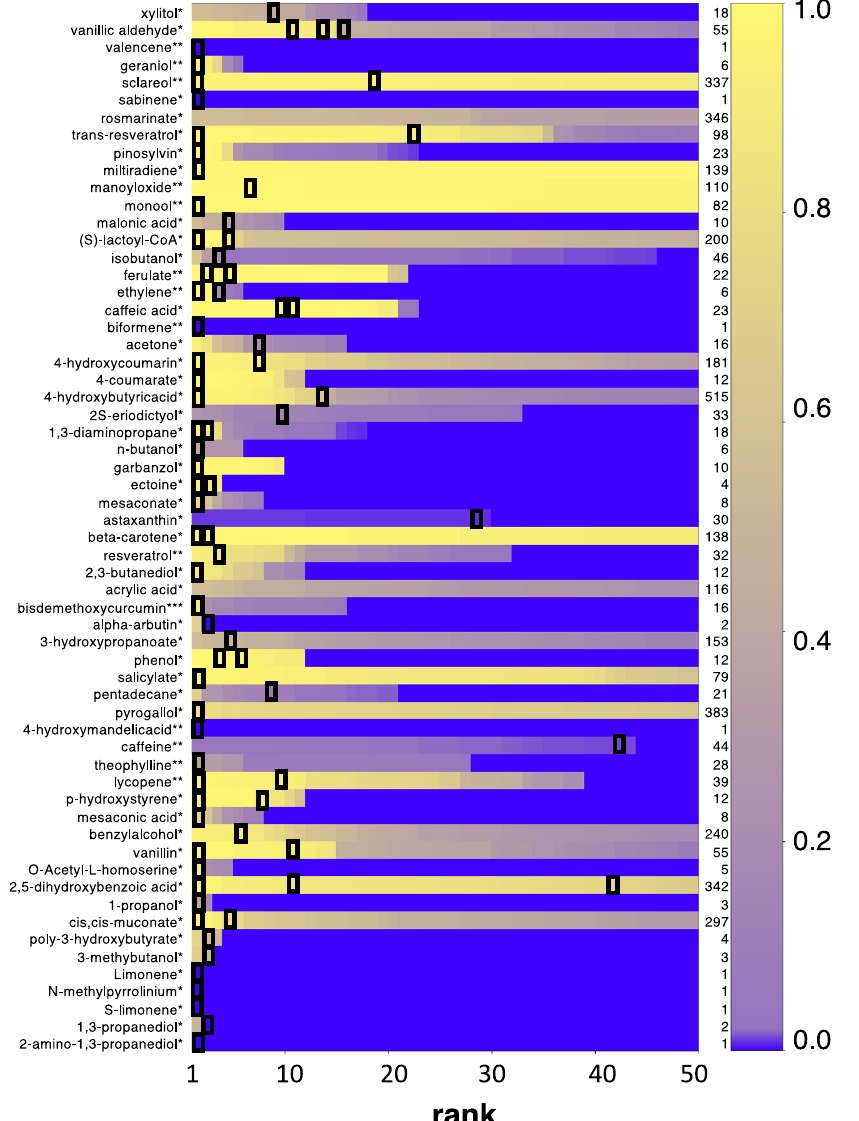
Fig. 3 | Ranking predicted pathways with machine learning global score. The colorcodeontherightsideshowsthemachinelearningglobalscore(from1topto 0).Theblackboxesshowthelocationoftheliteratureorexpertselectedpathways for a set 60 literature target engineered in E. coli (*), S. cerevisiae (**) or P. putida (***). If a row does not contain a black box, then the literature or expert selected